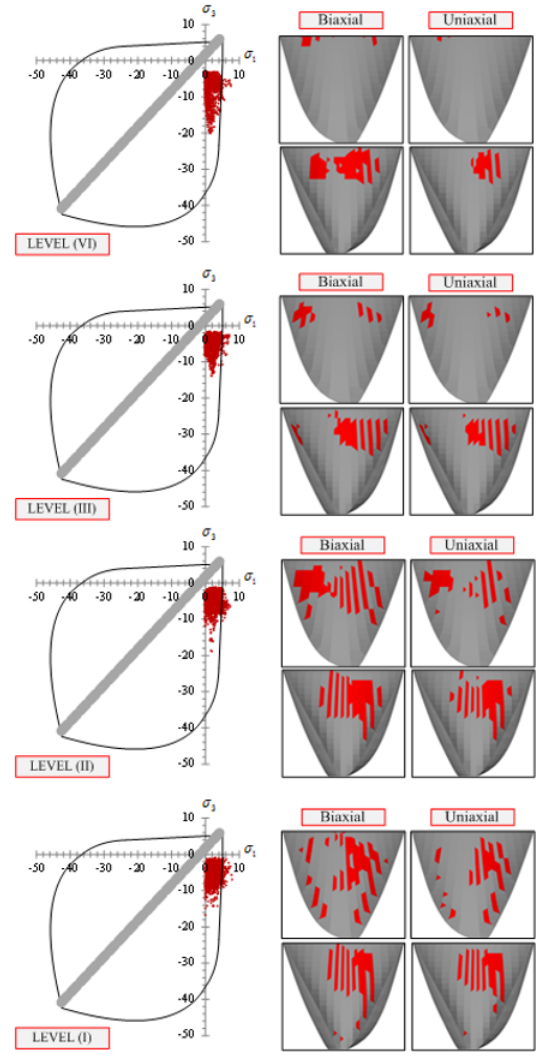
Figure 21. Distribution of principal stresses within the dam body us- ing biaxial failure